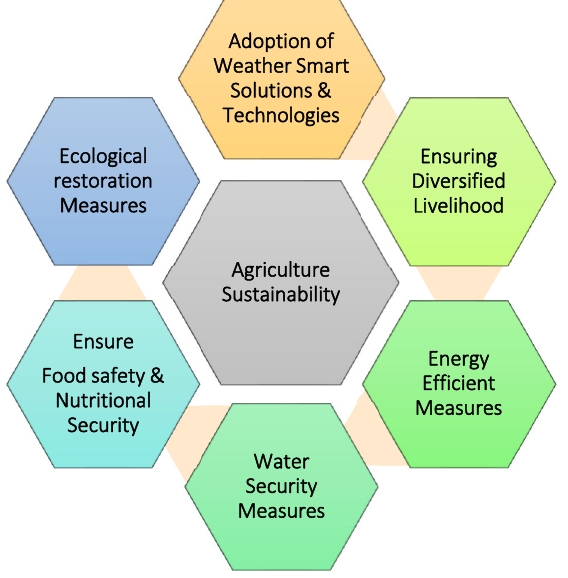
Figure 1. Ways to achieve sustainable agriculture production (author formulated).